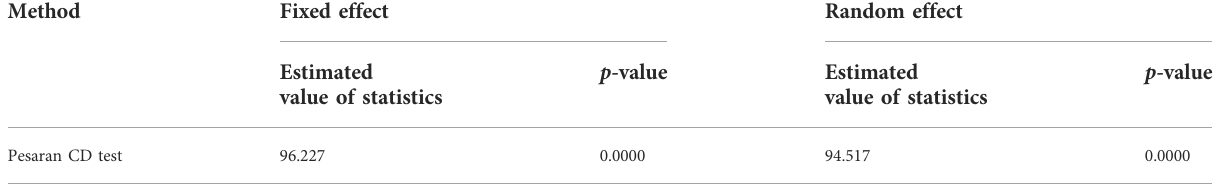
TABLE 2 Estimated value and signi fi cance level of Pesaran ’ s CD test.